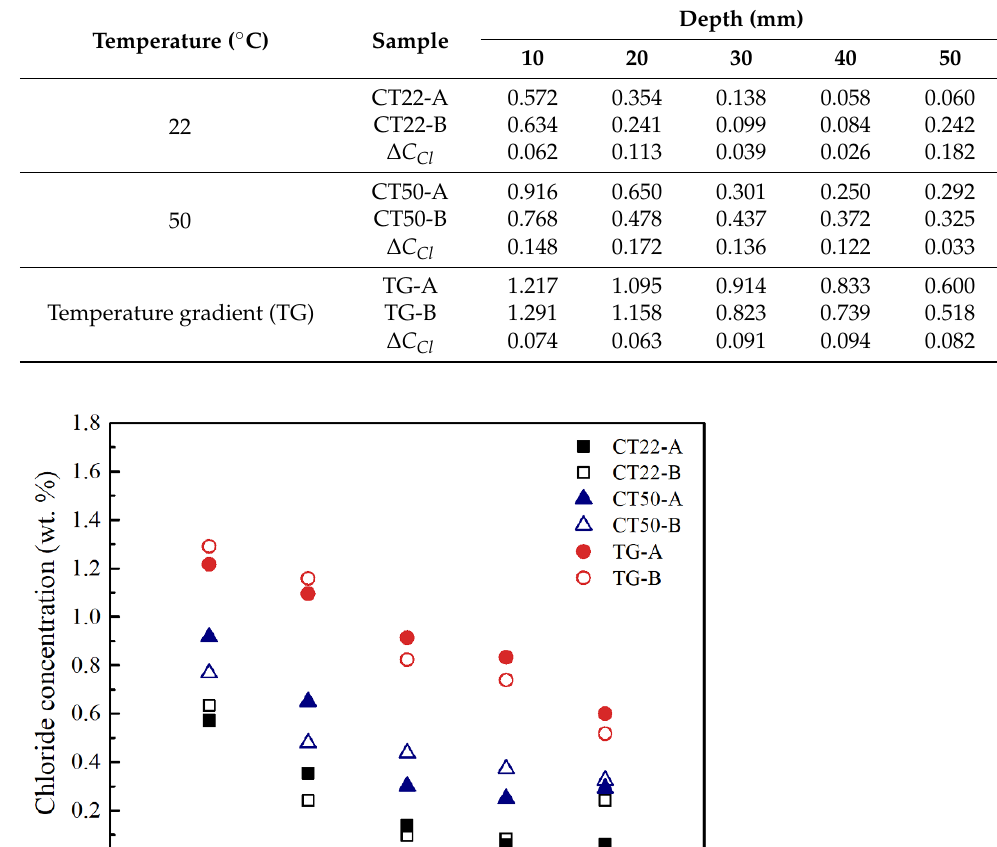
Table 2. Chloride concentrations ( C Cl ) of concrete samples determined via potentiometric titration. (wt. % of concrete).